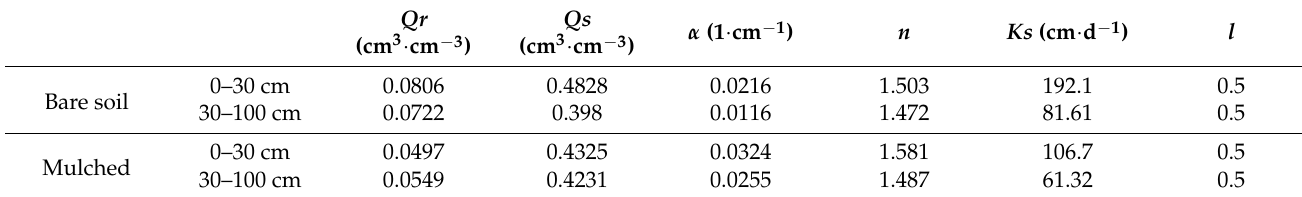
Table 2. Model parameters to simulate soil water flow.